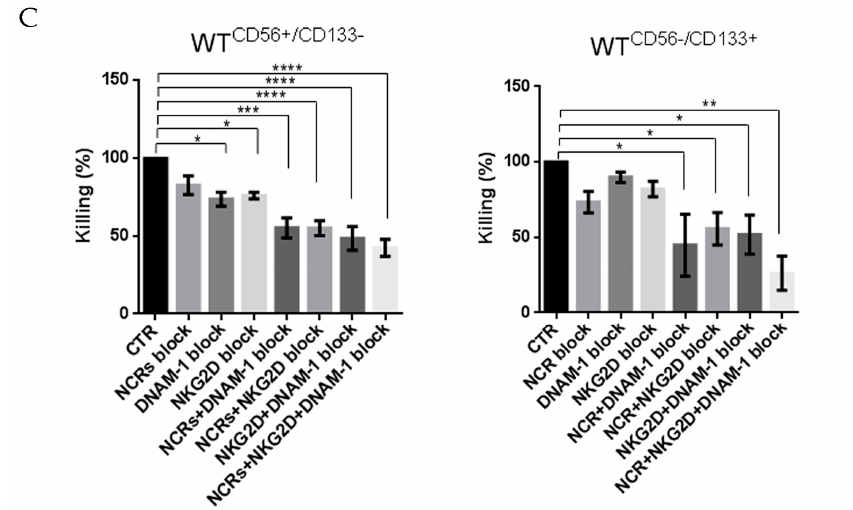
2 Figure 2. NK-mediated cytolysis of WT cell lines and ligand recognized by some activating and inhibitory receptors ( A ). The cytotoxicity assay of activated NK from healthy donors against WT cell lines. NK cells were incubated with WT cells for 4 h at the indicated E:T ratio. Data are the mean of four independent experiments for each WT cell line ± SEM. The NK susceptible K562 target cells were used as control. ( B ) Surface expression of NK receptor ligands: CD112, CD155, MIC A/B, ULBP 2/5/6, HLA I, and PDL-1 in a representative experiment. ( C ) Role of NCRs, DNAM-1, and NKG2D in killing WT cell lines. NK cells were incubated with WT cells (1:20 E:T ratio) in the absence or in the presence of saturating amounts (10 µ g/mL) of anti-DNAM-1 and anti-NKG2D and multiple anti-NCRs blocking antibody. The graph shows the killing efficiency expressed as percentage of the killing observed with the control. The cytotoxicity assay data shown are obtained from single WT-CD133 + /CD133 − and WT-CD56 − /CD133 + cell cultures as target and activated NK cells purified from three healthy donors. Bar graphs are the mean ± SEM. p -values were calculated using one-way ANOVA with Dunnett’s multiple comparisons test (* p < 0.05, ** p < 0.01, *** p < 0.001, **** p <